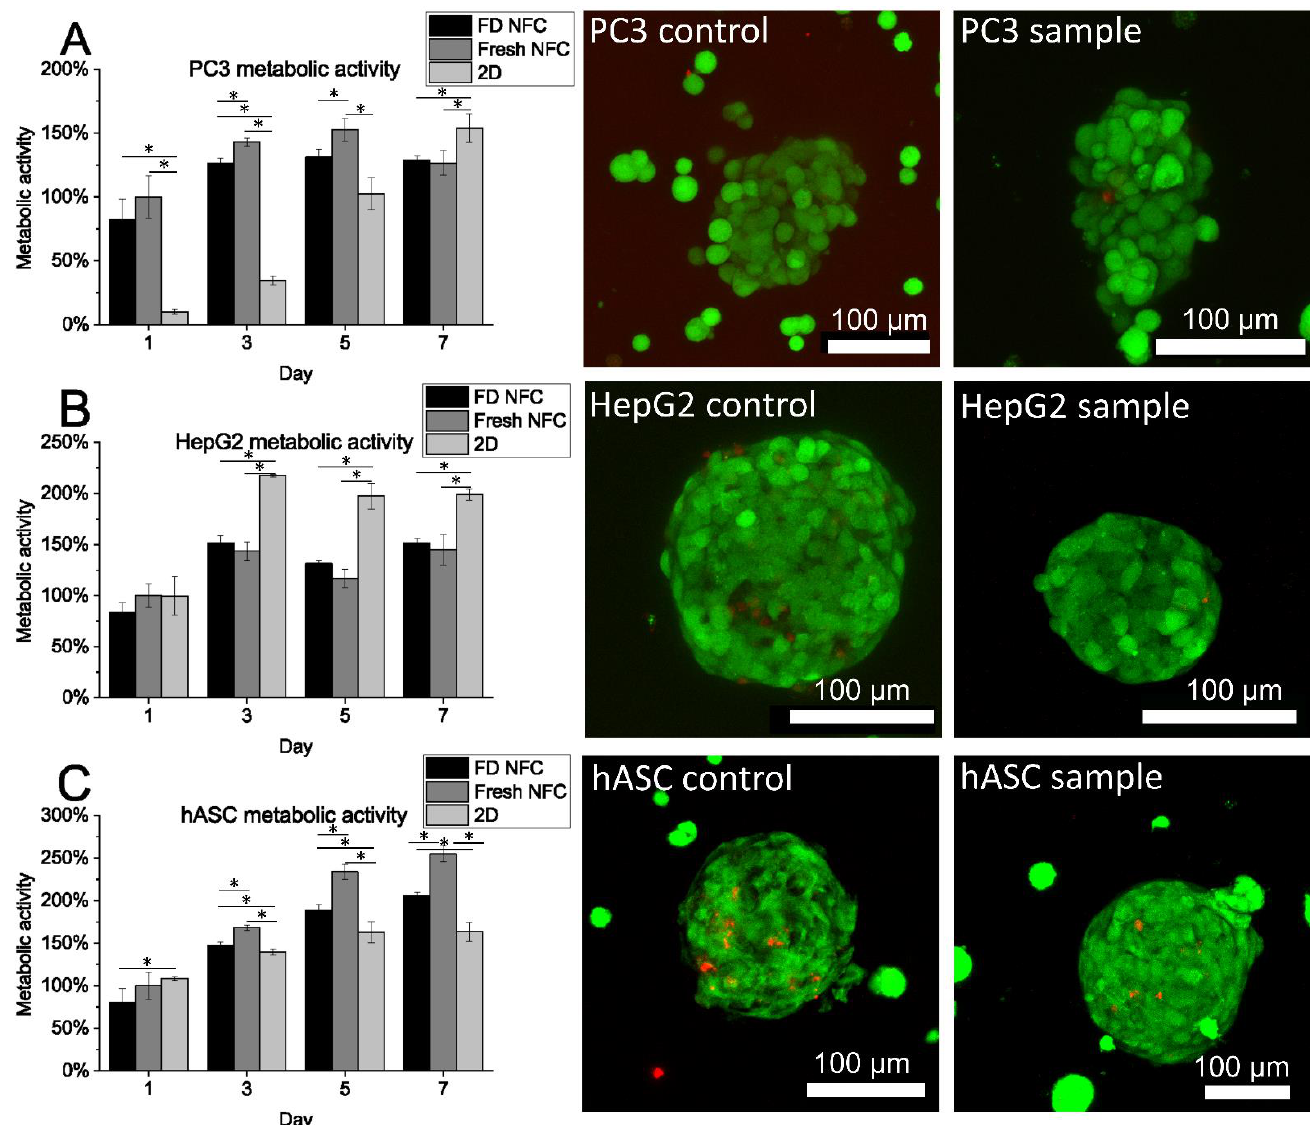
Figure 2. ( A ) Metabolic activity and viability of prostate cancer (PC3) cells cultured in freeze-dried and reconstituted 1.0% nanofibrillated cellulose (NFC) hydrogel, fresh 1.0% NFC hydrogel, and in 2D format. ( B ) Metabolic activity and viability of hepatocellular carcinoma (HepG2) cells cultured in freeze-dried and reconstituted 0.8% NFC hydrogel, fresh 0.8% NFC hydrogel, and 2D format. ( C ) Metabolic activity and viability of human adipose stromal/stem cells (hASCs) cultured in freeze-dried and reconstituted 0.125% NFC hydrogel, fresh 0.125% NFC hydrogel, and 2D format. Live/dead staining was performed on day 7 for all cell lines. Green: viable cells. Red: Dead cells. FD: Freeze-dried. Columns represent average values normalized to the metabolic activity of the specimen of day 1 fresh NFC. Error bars: standard deviation. Asterix: Statistically significant difference (two-tailed independent samples t-test, p < 0.05 considered significant).